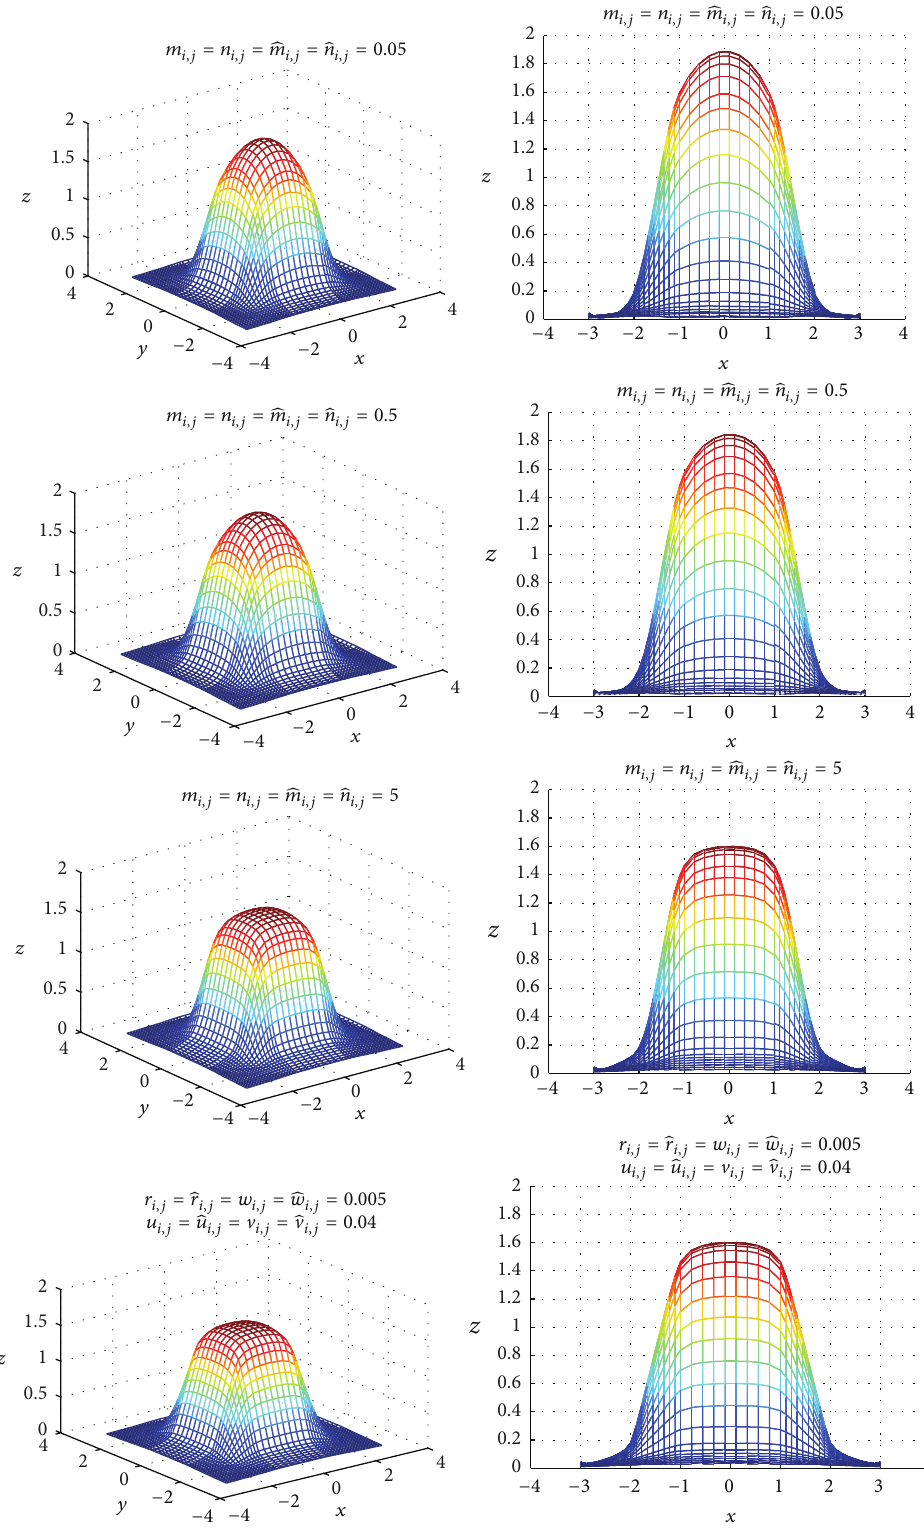
Figure 1: Surfaces generated from the given positive surface data set in Table 1. The first three rows are our biquartic rational interpolation spline surfaces with different shape parameters, and the last row is the surface in [5] with given